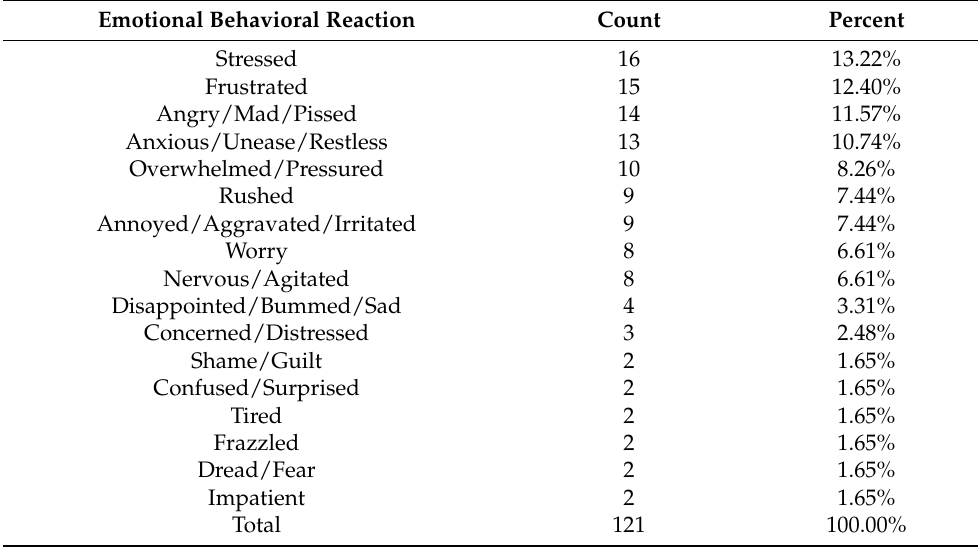
Table 1. Emotional behavioral reaction frequencies in the occupational stress diaries. Emotional Behavioral Reaction